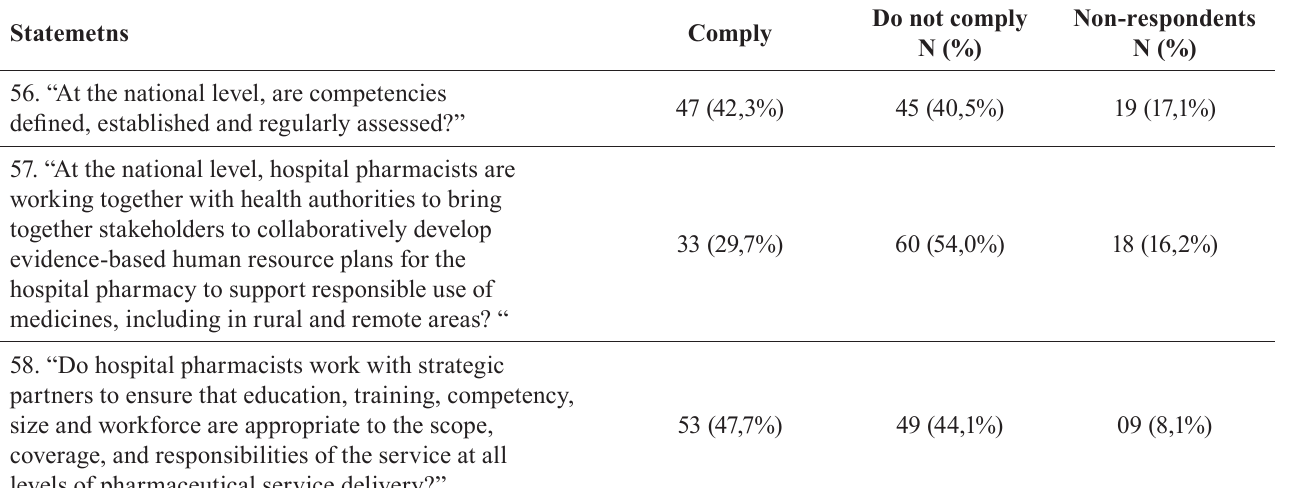
Table II - Evaluation of human resources, training and development of hospital pharmacies (N = 111)